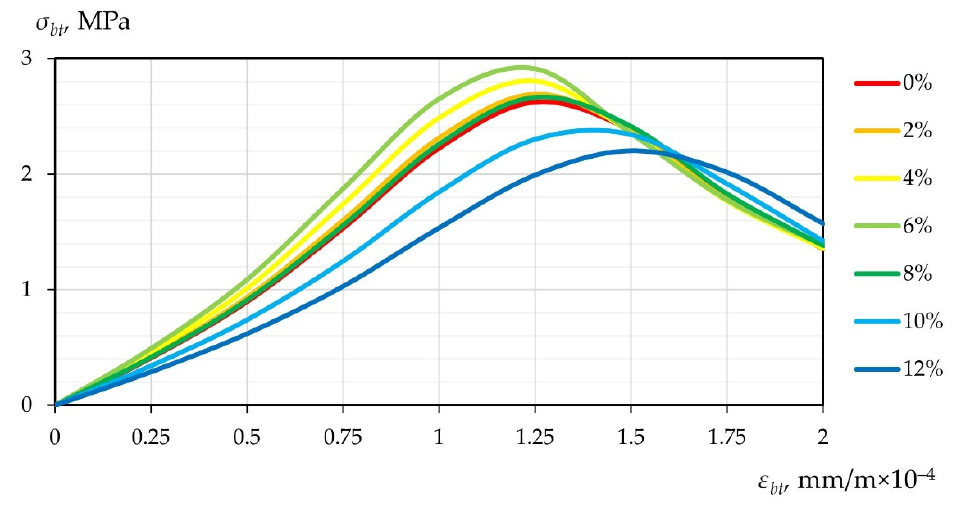
Figure 11. Stress–strain diagram in tension.